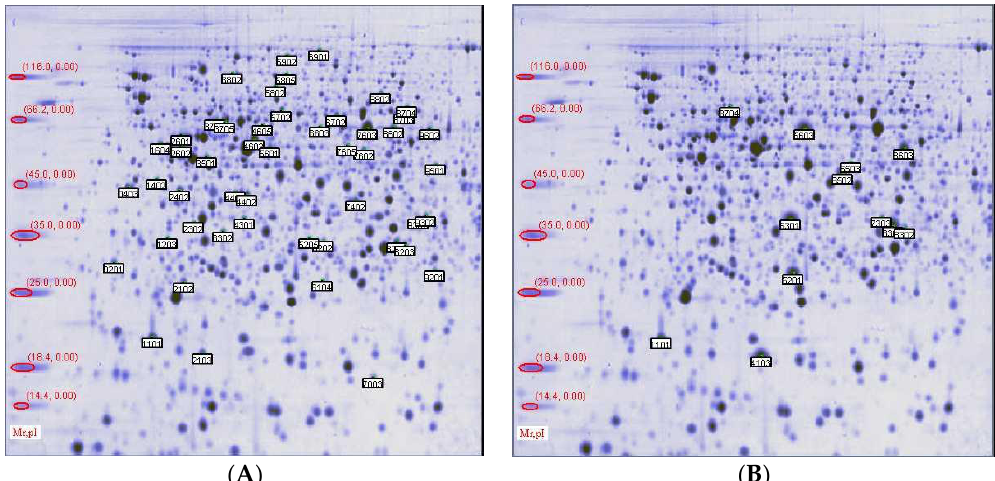
Figure 2. Two-dimension gel electrophoresis of proteins from liver extract stained with Coomassie Brilliant Blue. pH 3−10 nonlinear first dimension, and 12% SDS–PAGE second dimension. ( A ) shows that there were 73 differential spots in the drug-treated group compared with model group; ( B ) shows that there were 22 differential spots in the drug-treated group compared with control group. Differentially expressed proteins are marked in each spot sustained an individual identification number (SSP).